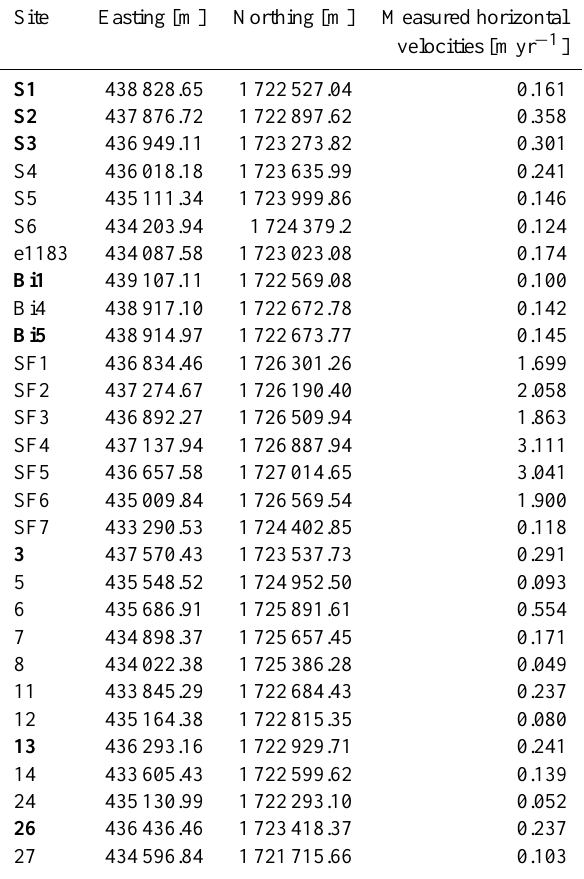
Table 2. Measured surface velocities. Point sites within the inner BIA are indicated with bold letters. Coordinates are in UTM 29